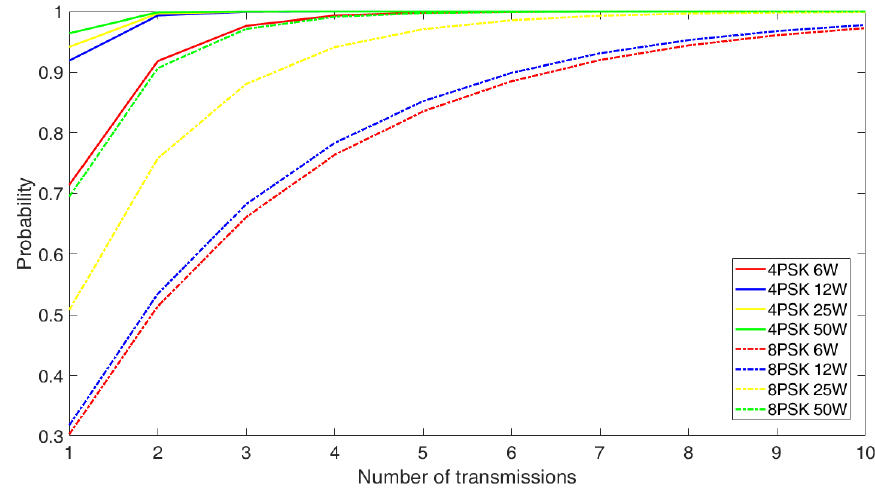
Figure 12. Number of transmissions according to selection combining.